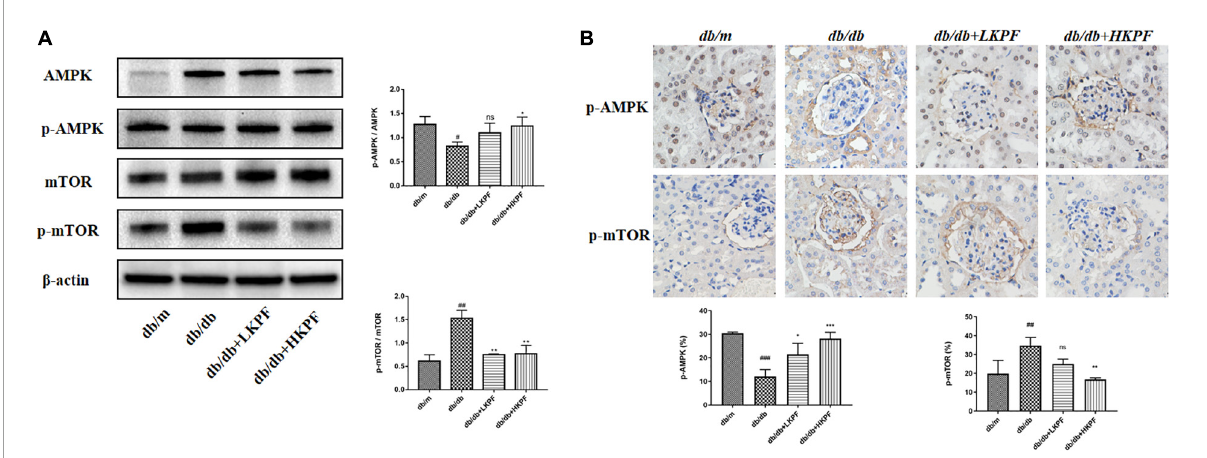
FIGURE6 Kaempferol regulated AMPK/mTOR pathways in the kidneys of db/db mice. (A) WB assay and quantitative analysis of AMPK, p-AMPK, mTOR, and p-mTOR expressions after Kaempferol treatment, β -actin was used as internal references; data from each group are expressed as the mean ± SD ( n = 3) from three repeated WB experiments. (B) IHC assay and quantitative analysis of p-AMPK and p-mTOR expressions (400 × , n = 3). ( ## p < 0.01 and ### p < 0.001 vs. db/m mice; *p < 0.05, **p < 0.01, and ***p < 0.001 vs. db/db mice; ns, not significant). IHC, Immunohistochemical; WB, Western